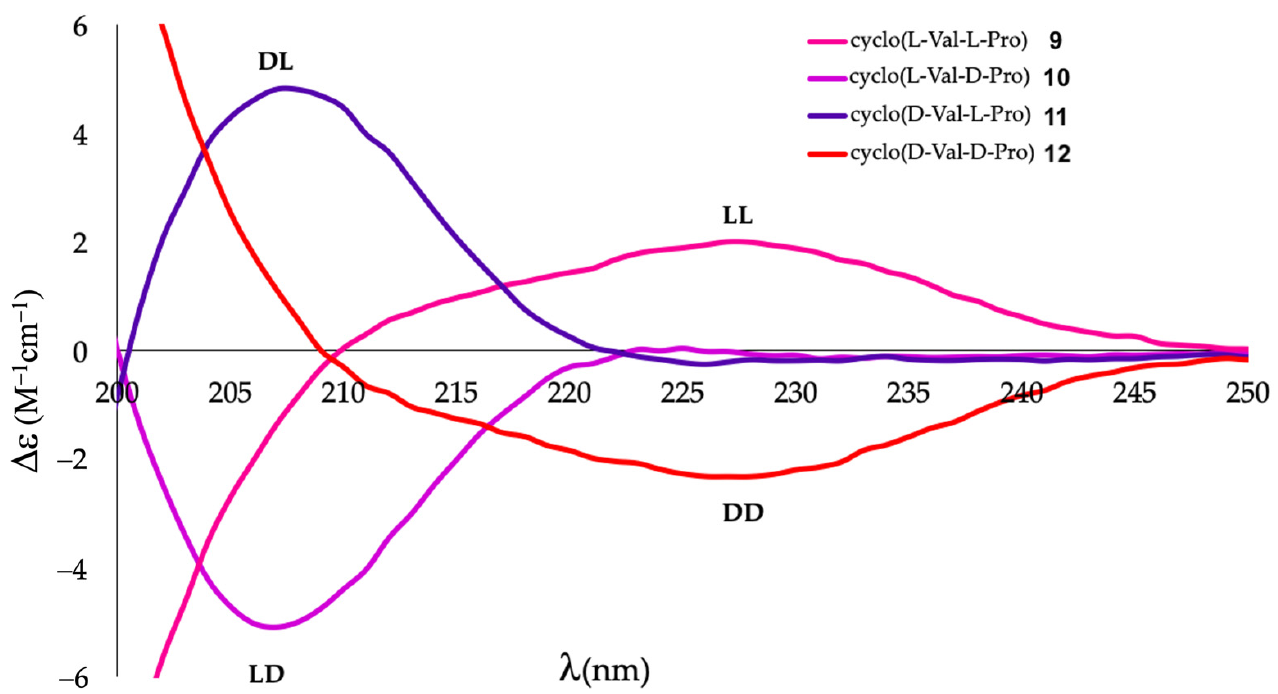
Figure 4. ECD spectra of synthetic cyclo(Val-Pro) isomers in methanol (spectroscopic grade).